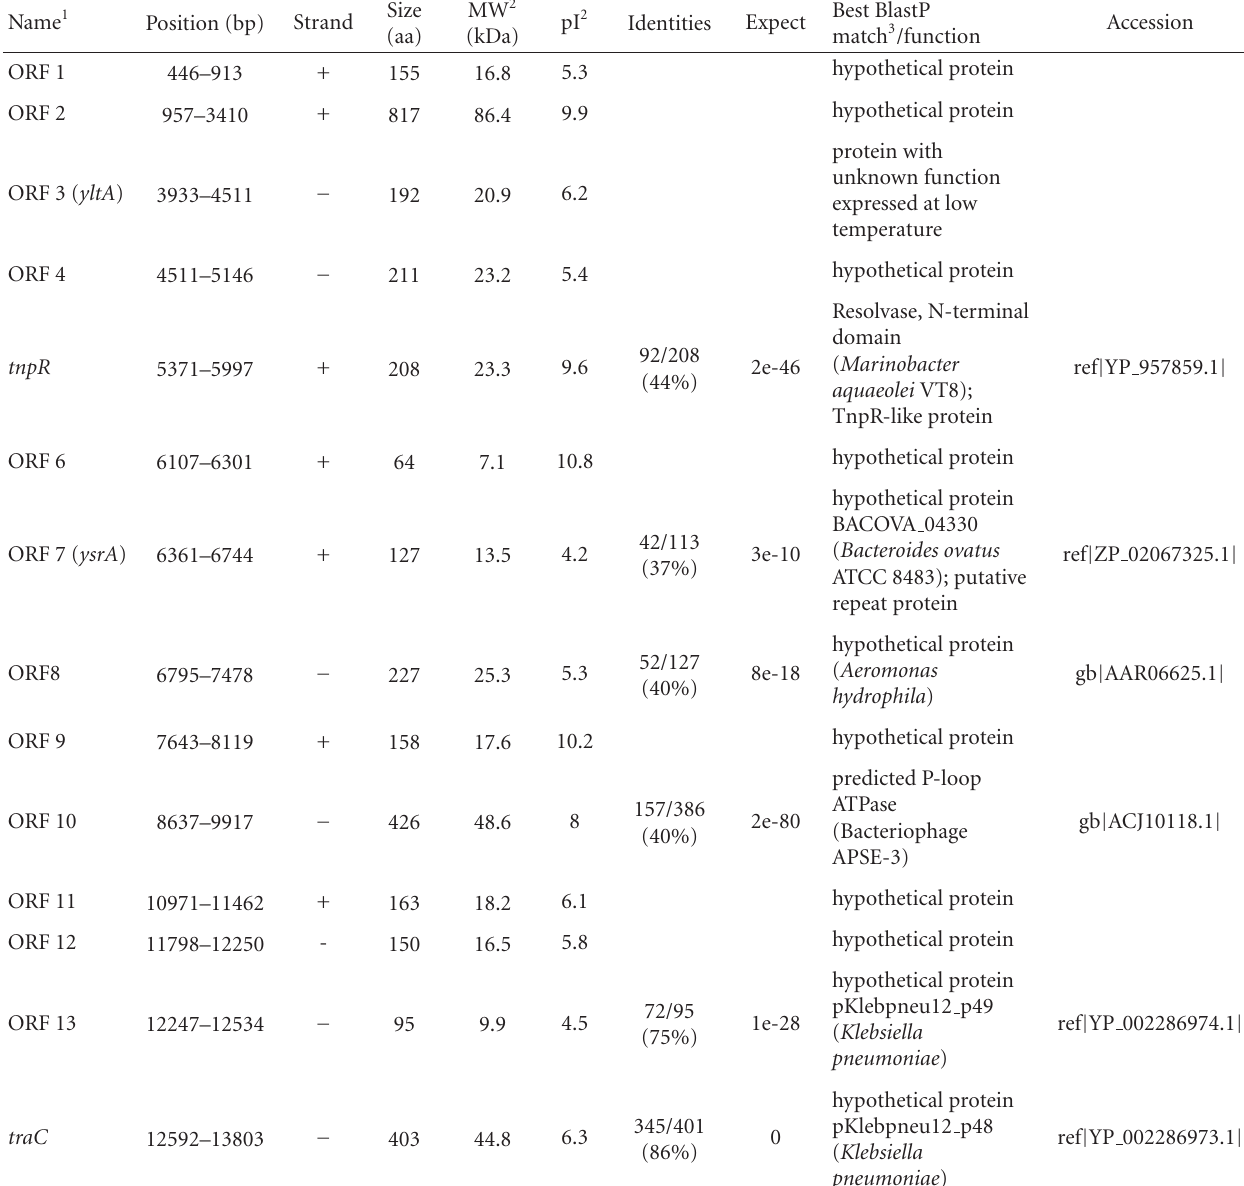
Table 2: ORFs identified on plasmid